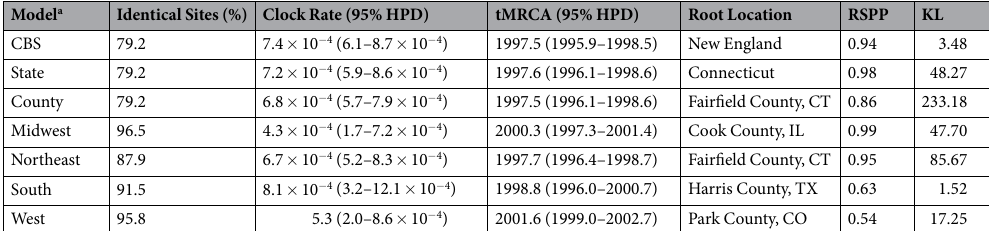
Table 2. Posterior statistics of the MCC phylogenies. a Results not available for the CBR phylogeny as its predictor design matrix did not achieve full